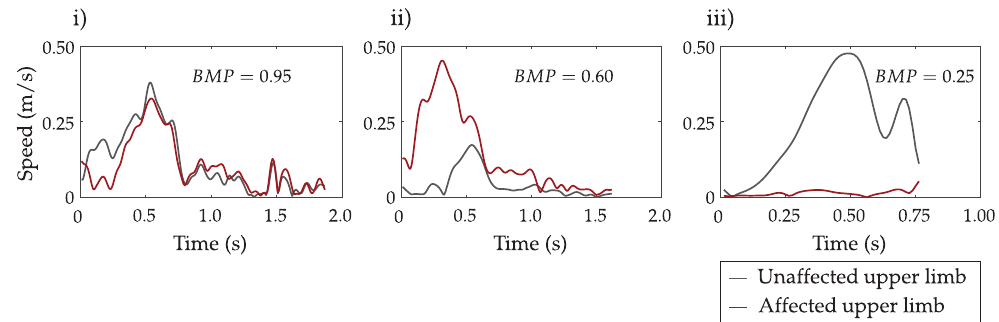
Figure 7. Representative examples of bimanual movements of a patient with an upper limb impair- ment for BMP = 0.95 ( i ), BMP = 0.60 ( ii ), and BMP = 0.25 ( iii ). Black colour represents the speed of the unaffected arm and the red colour represents the speed of the affected